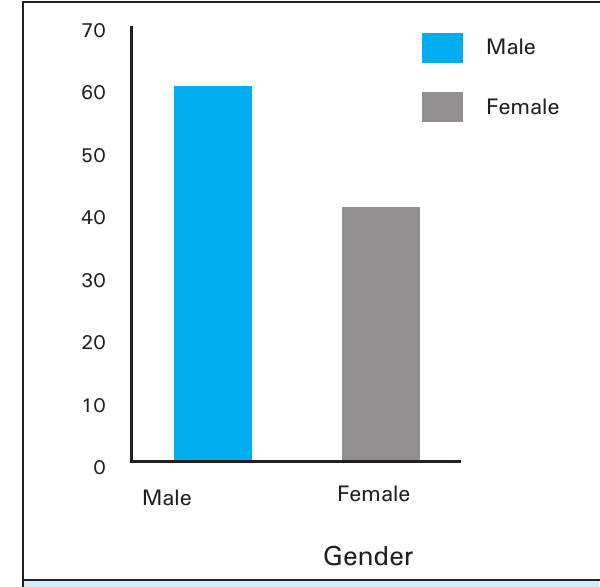
Figure 1. Gender distribution of